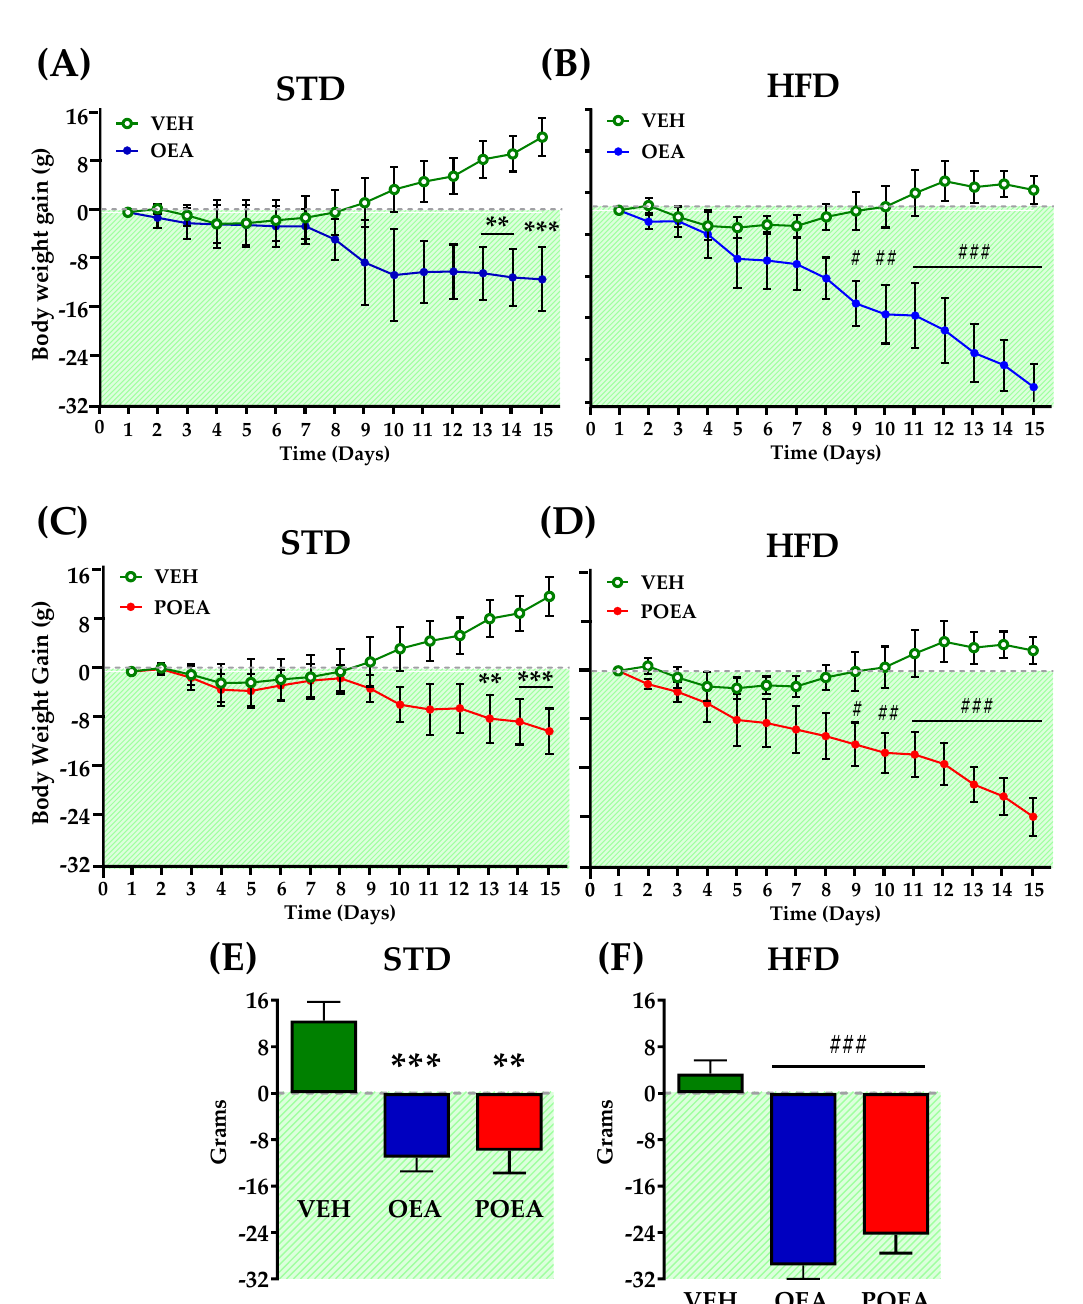
Figure 4. Effects of sub-chronic (15 days) administration of a 10 mg/kg dose of either oleoylethanolamide (OEA) ( A , B ) or palmitoleylethanolamide (POEA) ( C , D ) in animals fed with either a standard diet (STD) or hypercaloric cafeteria diet (HFD). Data are the evolution of cumulative body weight gain in male Sprague–Dawley rats. (Panels E , F ) show the total weight gain variation after 15 days of treatment. Points or bars are means ± standard error of the mean (SEM) ( n = 8 animals per group). Data were analyzed by two-way ANOVA (diet and time) and Bonferroni’s post hoc test. (**) p < 0.01, and (***) p < 0.001, significant differences compared with vehicle (VEH) STD group. (#) p < 0.05, (##) p < 0.01, and (###) p < 0.001 significant differences compared with VEH HFD group.